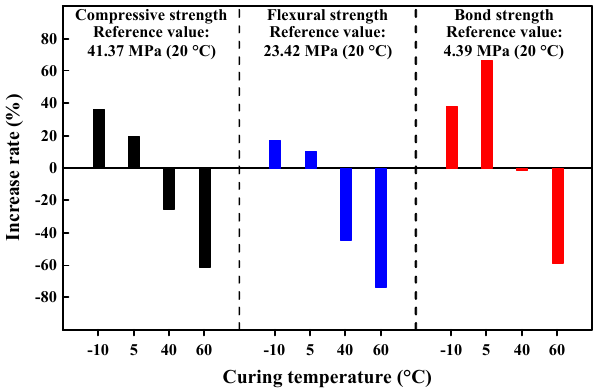
Figure 9. Comparison of rates of increase in compressive, flexural, and bond strengths as a function of curing temperature.